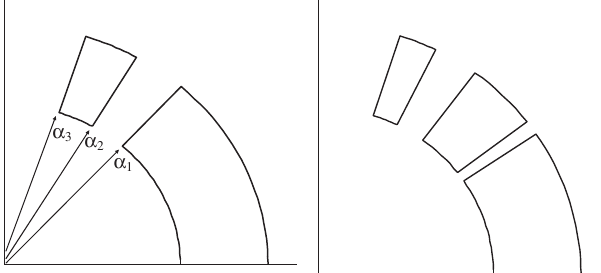
FIG. 4. Two sector layouts (one fourth shown in the plot), one with two blocks [0 (cid:12) –43.2 (cid:12) , 52.2 (cid:12) –67. 3 (cid:12) ] (left) and one with three blocks [0 (cid:12) –33.3 (cid:12) , 37.1 (cid:12) –53. 1 (cid:12) , 63.4 (cid:12) –71.8 (cid:12) ]